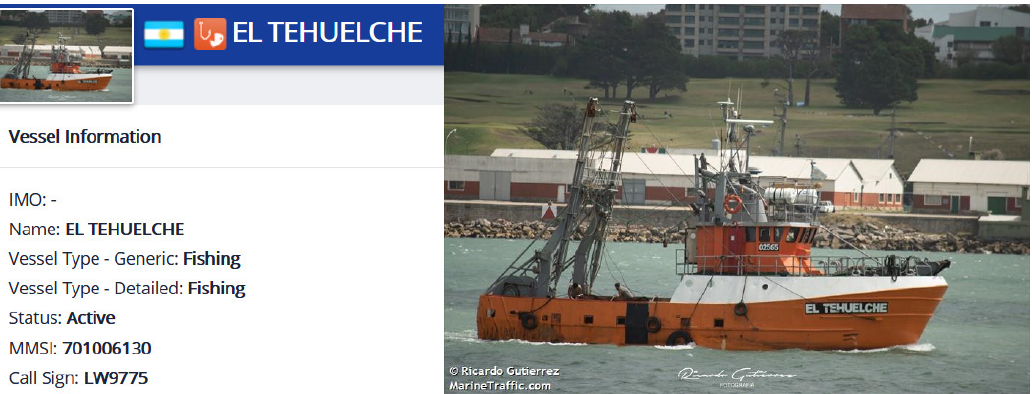
Figure 9. The registration information and photos of the ship (MMSI: 701006130) on the Marine Traffic website.